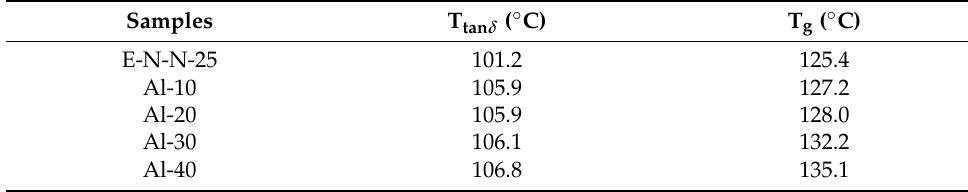
Table 3. Characteristic temperatures of the Al-based model propellants.